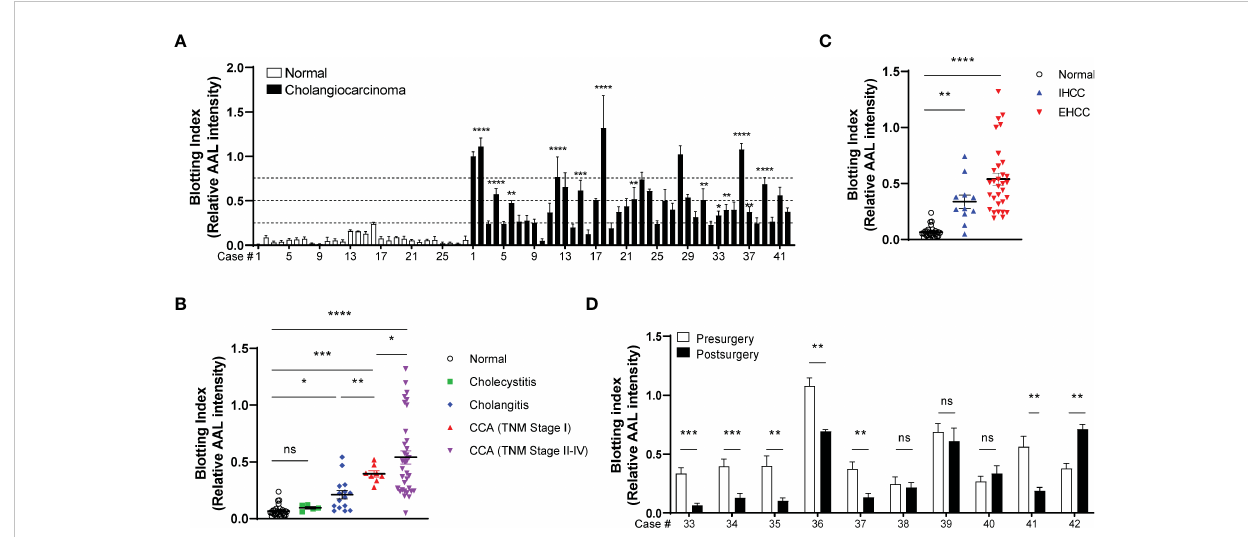
FIGURE 7 Diagnostic and prognostic value of EV-Hp fucosylation in CCA. Quantitative data are shown as mean ± S.E.M. Statistical analysis was performed using the two-tailed Student ’ s t-test. ****p < 0.0001, ***p < 0.001, **p < 0.01, *p < 0.05, ns, p > 0.05. (A) AAL blotting for EV-Hp of CCA and healthy volunteers. The fucosylation level was examined using a blotting index; n = 7. (B) Comparison of EV-Hp fucosylation for different stages of CCA, in fl ammatory conditions, and normal. (C) Effect of tumor location on EV-Hp fucosylation. IHCC, intrahepatic cholangiocarcinoma. EHCC,